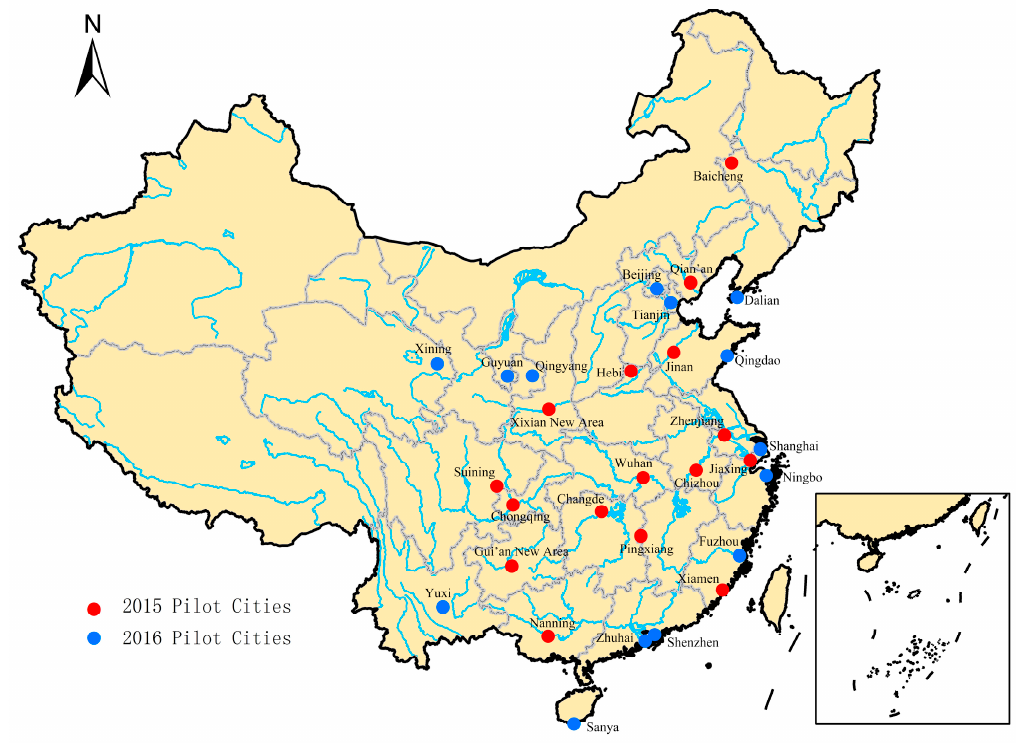
Figure 2. Location of pilot sponge cities.